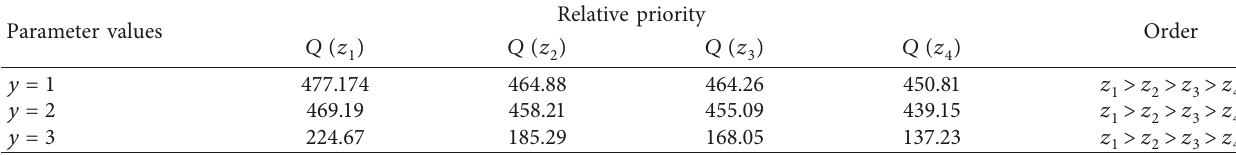
Table 18: Order for different parameters with LFFWHM operator using the COPRAS method.